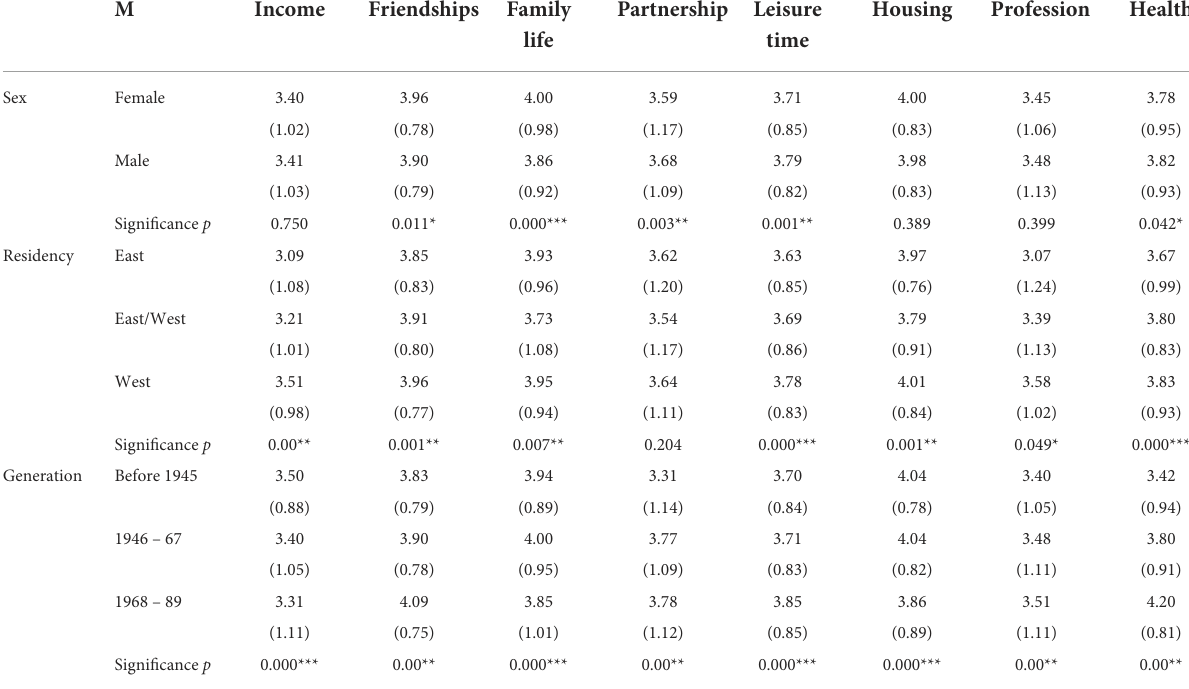
TABLE 2 Participants’ dimensions of life satisfaction by sex, generation, and residency. M Income Friendships Family